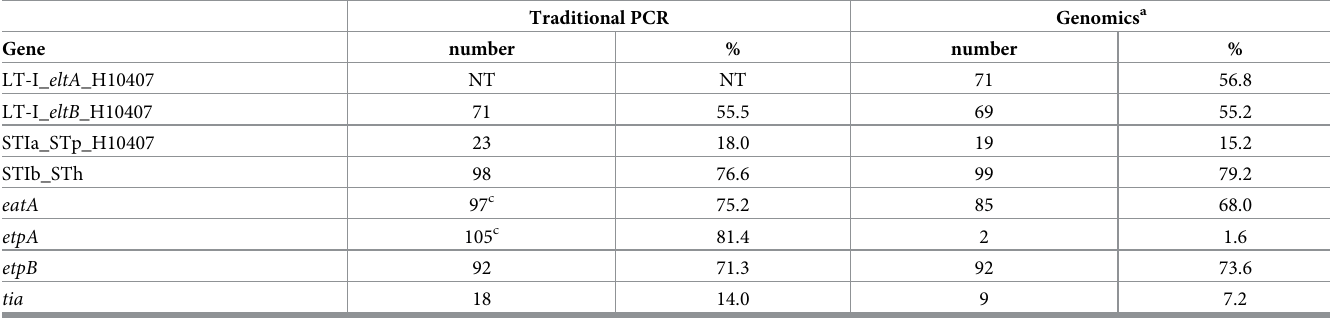
Table 2. Virulence factor prevalence a .